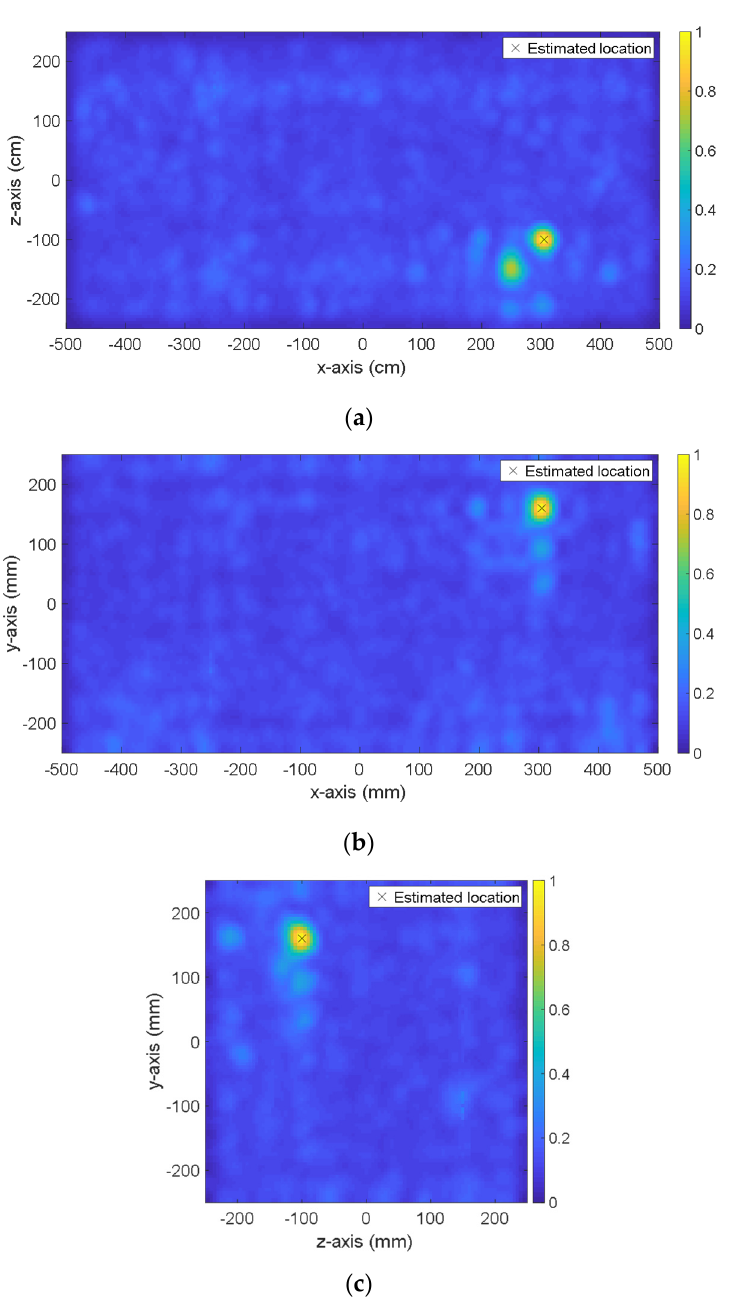
Figure 12. The distribution of normalized maximum electric field power over the complete simulation time interval in the computational domain for ( a ) cut-plane y = 0.16 m, ( b ) cut-plane z = − 0.10 m, and ( c ) cut-plane x = 0.3 m. The black crosses ( × ) show the estimated location for the PD source. The localization error of the proposed EMIF method is 5 mm. In Equation (8), the parameter α used in the EMIF method is 0.9.